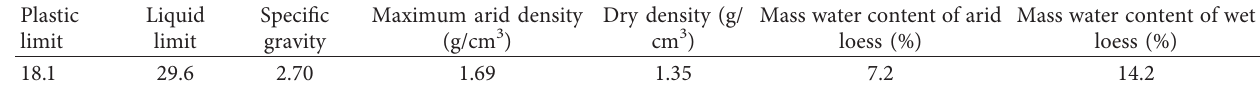
Table 3: Physical properties of loess samples for water migration